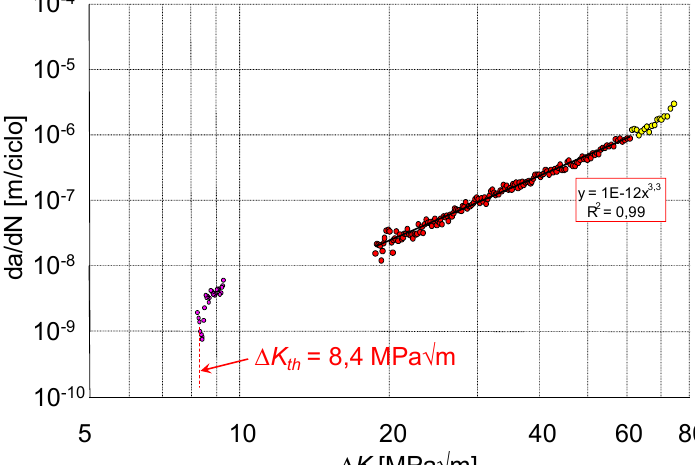
Figura 5: Determinazione sperimentale di curve di propagazione di cricca per una struttura perlitica (a) e del relativo valore di Δ K di soglia, Δ K th (b) (R= 0,1) [5]. Figure 5: Fatigue propagation rate tests for a pearlitic structure (a) and threshold Δ K th determination (b) (R= 0,1).